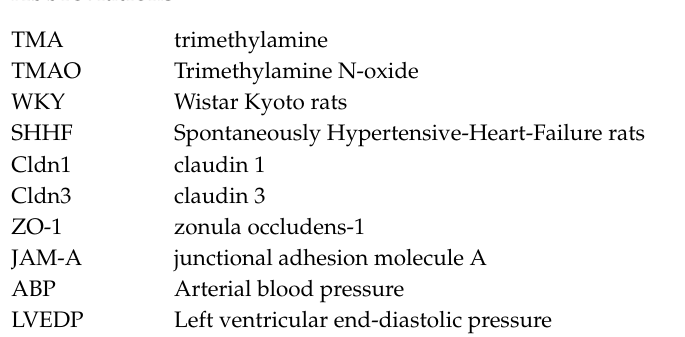
s1. Figure S1. ( A ) Electrocardiograph and ( B ) echocardiograph recordings in healthy Wistar Kyoto rats (WKY) and spontaneously hypertensive-heart failure rats (SHHF); Figure S2. Histological images of the lungs; Figure S3. Recordings of arterial blood pressure (BP), heart rate (HR) and intestinal blood flow (IBF) in healthy Wistar Kyoto rats (WKY) and spontaneously hypertensive heart failure rats (SHHF); Figure S4. Uncropped immunoblots from Figure 6; Figure S5. Uncropped immunoblots from Figure 4; Table S1. List of oligonucleotide primers used for RT-qPCR; Table S2. List of antibodies used for Western blot